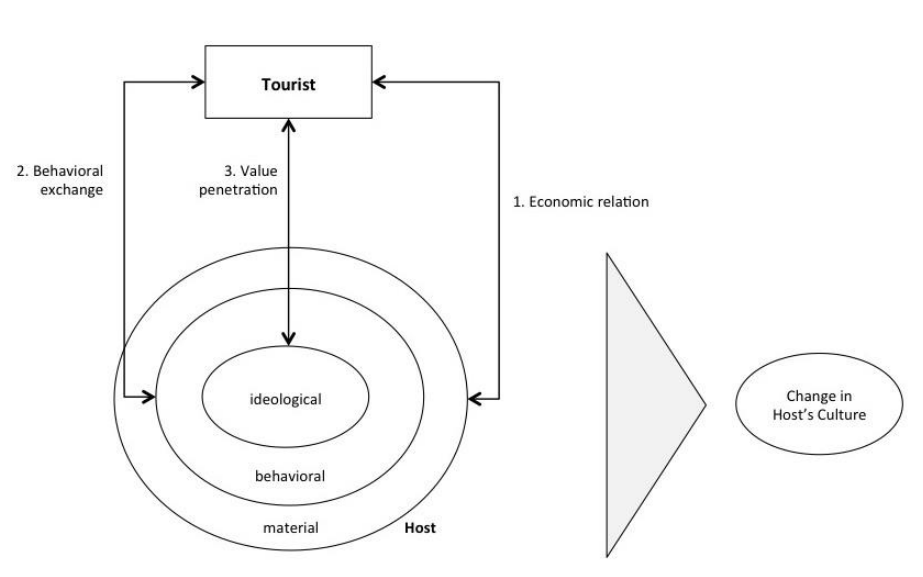
Figure 5. Intercultural Exchange between Host and Visitors (Source: Böhm,